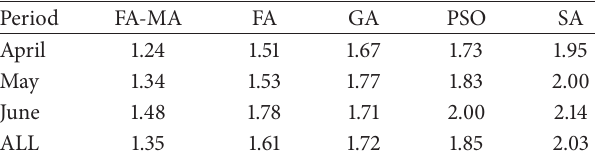
Table 3: MAPE (%) of SVR model with different parameter determination methods.